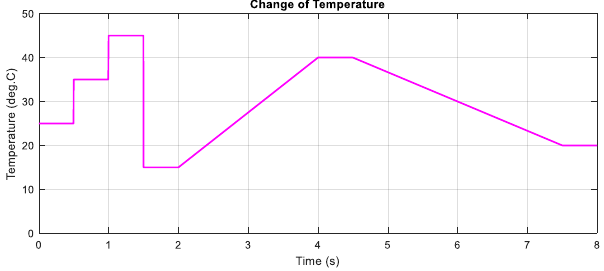
Figure 9. The change of temperature at G = 1000 W/m 2 .